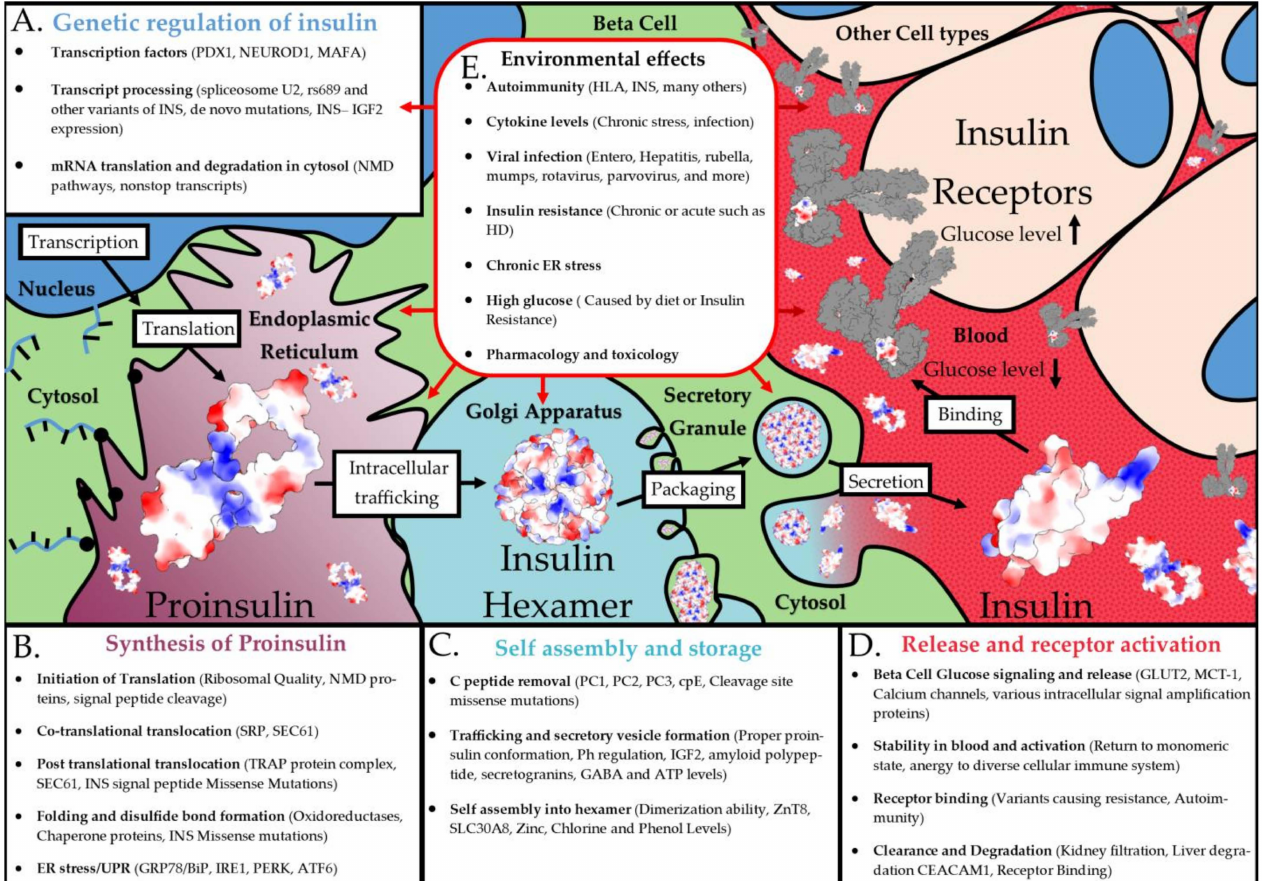
Figure 11. Environmental effects on the synthesis of insulin. Shown are factors involved in INS transcriptional regulation ( A ), proinsulin synthesis ( B ), insulin assembly/storage ( C ), and insulin release/receptor activation ( D ). This is shown overtop of an artistic rendering of the complex insulin biosynthesis. ( E ) Environmental factors that can potentially impact every step described in the prior